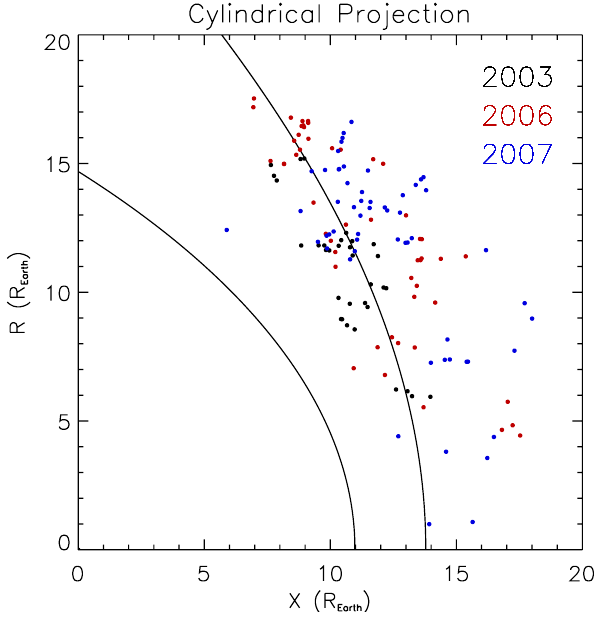
Fig. 2. Cylindrical projection of Cluster SC center positions dur- ing HFA observation and the average bow shock and magnetopause positions in GSE system. The shape of the magnetopause and the bow shock were calculated using the average solar wind pressure (Sibeck et al., 1991; Tsyganenko, 1995; Peredo et al., 1995). The black, red and blue points show the Cluster SC positions when HFA was observed in 2003, 2006 and 2007, respectively. The coordinates were plotted in R Earth units.